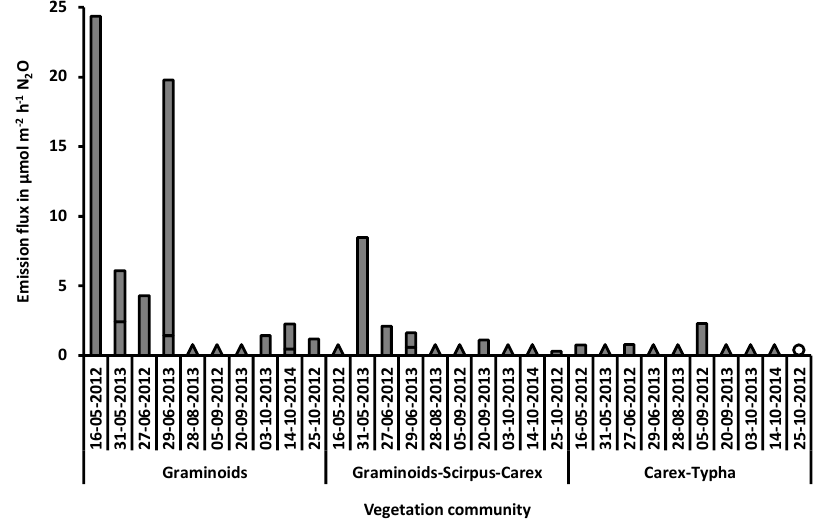
Figure 4. Nitrous oxide emission fluxes in the littoral zone on measurement occasions. Bars: median and maximum; triangles: all fluxes below detection limit; circle: no data. All minimum fluxes found were below detection limit. In 2009-2010, no detectable N 2 O fluxes were found at all.